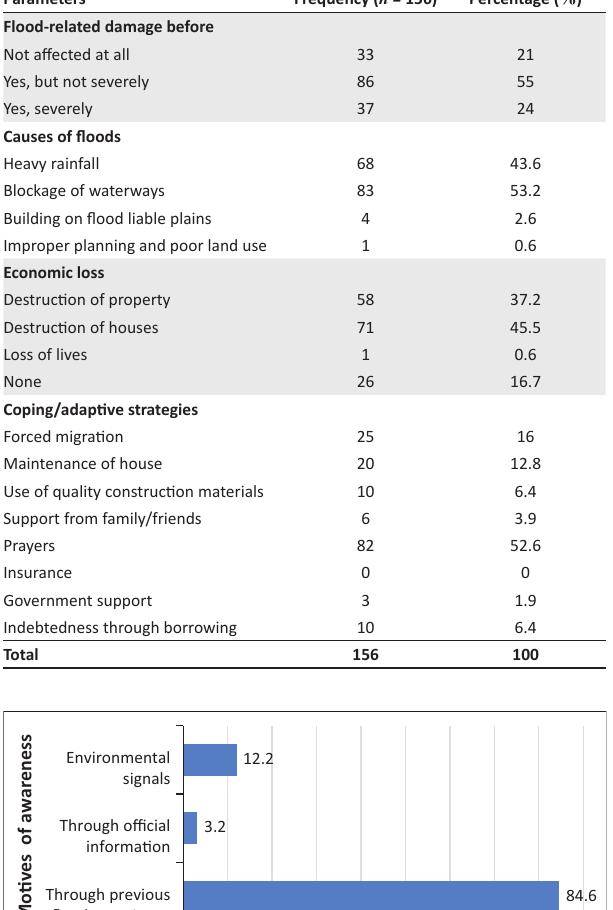
TABLE 4: Flood risk perception and adaptation strategies.